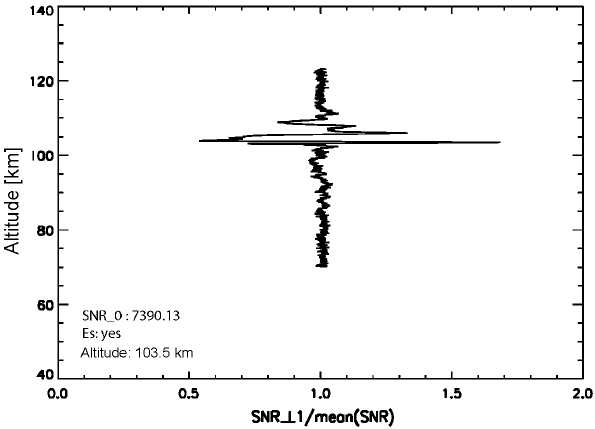
Figure 1. SNR profile of the GPS L1 signal showing strong fluctu- ations at 103km altitude caused by a sporadic E